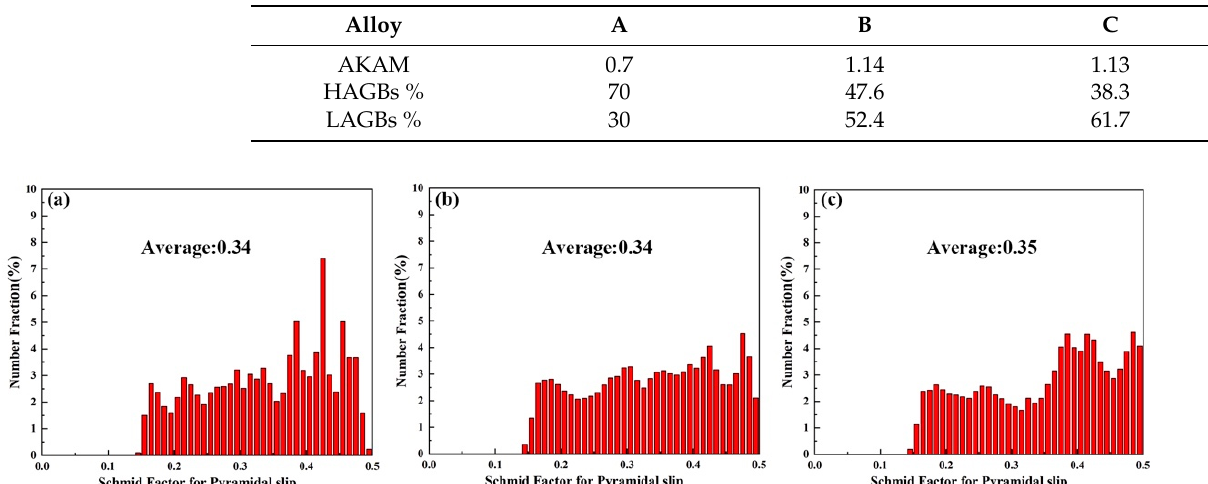
Figure 14. KAM diagram and grain boundary diagram near the alloy fracture, ( a , d ) Alloy A, ( b , e ) Alloy B, ( c , f ) Alloy C. Table 2. EBSD data table of alloys with different tensile conditions.